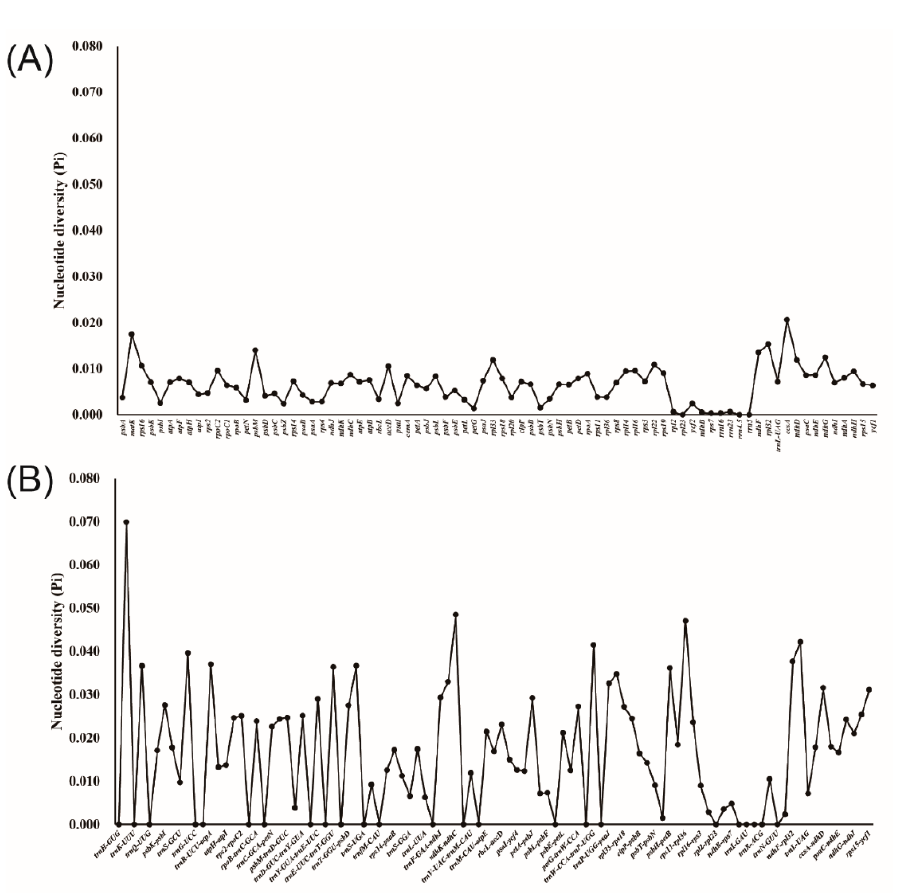
Figure 3. Comparative analysis of the nucleotide diversity (Pi) value among 17 Cardamine chloroplast genes. ( A ) Coding regions. ( B ) Non-coding regions. Table 4. The polymorphic SSRs among 17 Cardamine